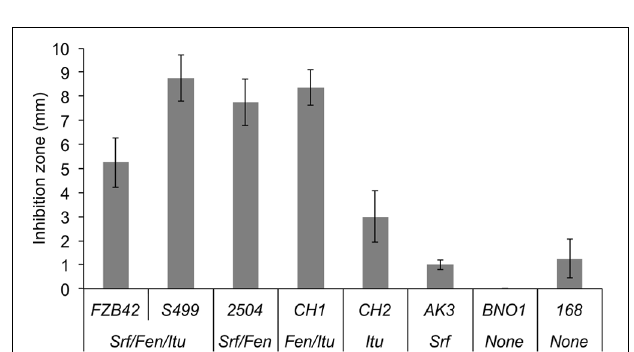
FIGURE 5 | Fengycins as main ingredients formed by S499 that are active to restrict growth of R. variabilis . Antifungal activity of various Bacillus strains against R. variabilis related to the type of CLP family (Srf: surfactins; Fen: fengycins; Itu: iturins; None: no CLPs) that they can produce. Strains unable to produce fengycins do not show any antifungal activity. Presented data are means and SD calculated from four biological